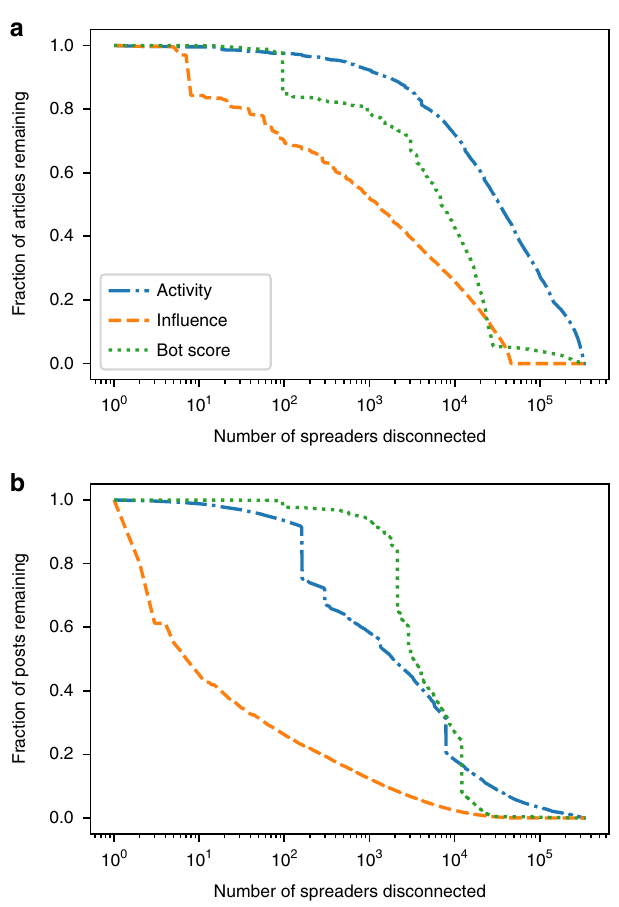
Fig. 5 Dismantling the low-credibility content diffusion network. This analysis is based on a network of retweets linking to low-credibility articles, collected during the 2016 US presidential campaign. The network has 227,363 nodes (accounts); see Methods for further details. The priority of disconnected nodes is determined by ranking accounts on the basis of the different characteristics shown in the legend. The remaining fraction of a unique articles from low-credibility sources and b retweets linking to those articles is plotted versus the number of disconnected nodes